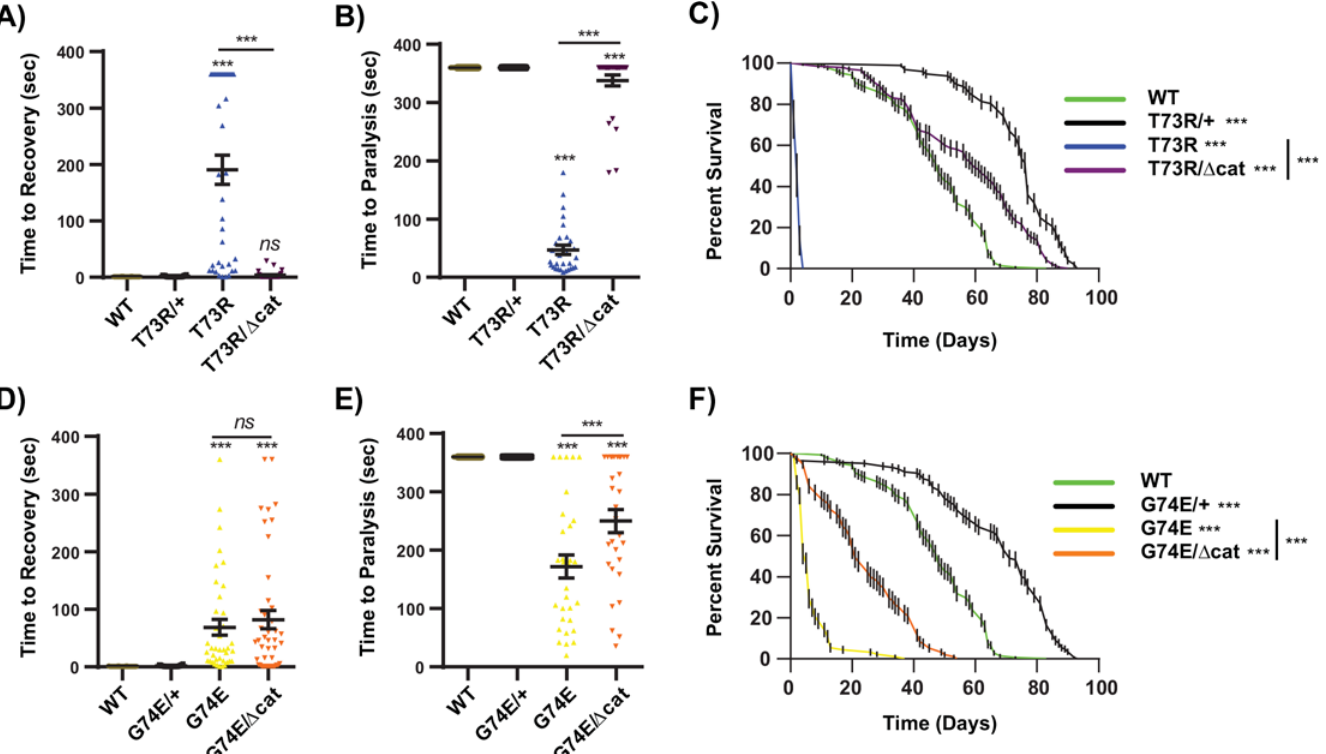
Fig 4. A catalytically inactive allele attenuates TPI dimer mutant behavior and longevity. (A) dTPI Δ cat complements dTPI T73R mechanical and (B) thermal stress sensitivity and (C) longevity, and (D,E) partially attenuates behavior and (F) longevity defects of dTPI G74E . Thermal stress paralysis times at 360 sec. represent wild type behavior, the assay was stopped at 6 min. n (cid:1) 30 for behavior, and n (cid:1) 90 for lifespans. Behavior was compared using a One-way ANOVA with Tukey ’ s post hoc test, and lifespans by a Log-rank (Mantel-Cox) survival test, ns indicates no significance, and *** p < 0.001.